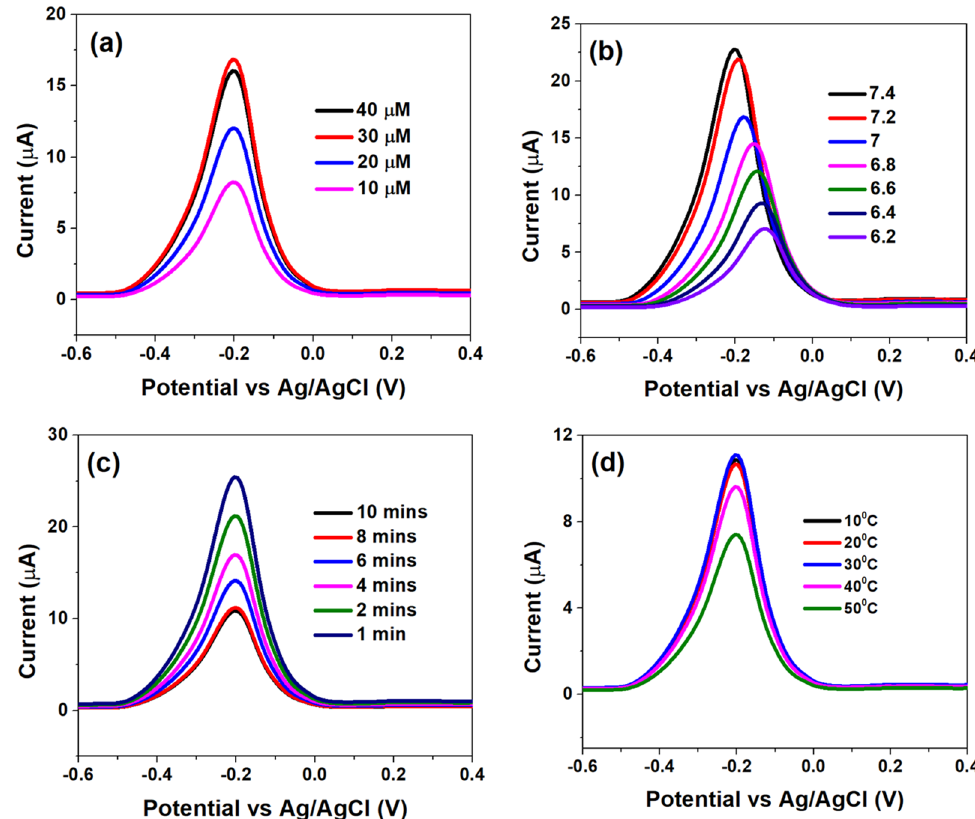
Figure 3. Differential pulse voltammograms obtained at ( a ) different HPV-16 PDNA concentrations, ( b ) various pH within 6.2–7.4, ( c ) incubation time of 1 µ M HPV-16 TDNA at PBS-MB (0.1 M/1 µ M, pH 7.4) and ( d ) effect of temperature variation on DNA hybridization, optimized at 10 min in PBS-MB (0.1 M/1 μ M, pH 7.4).